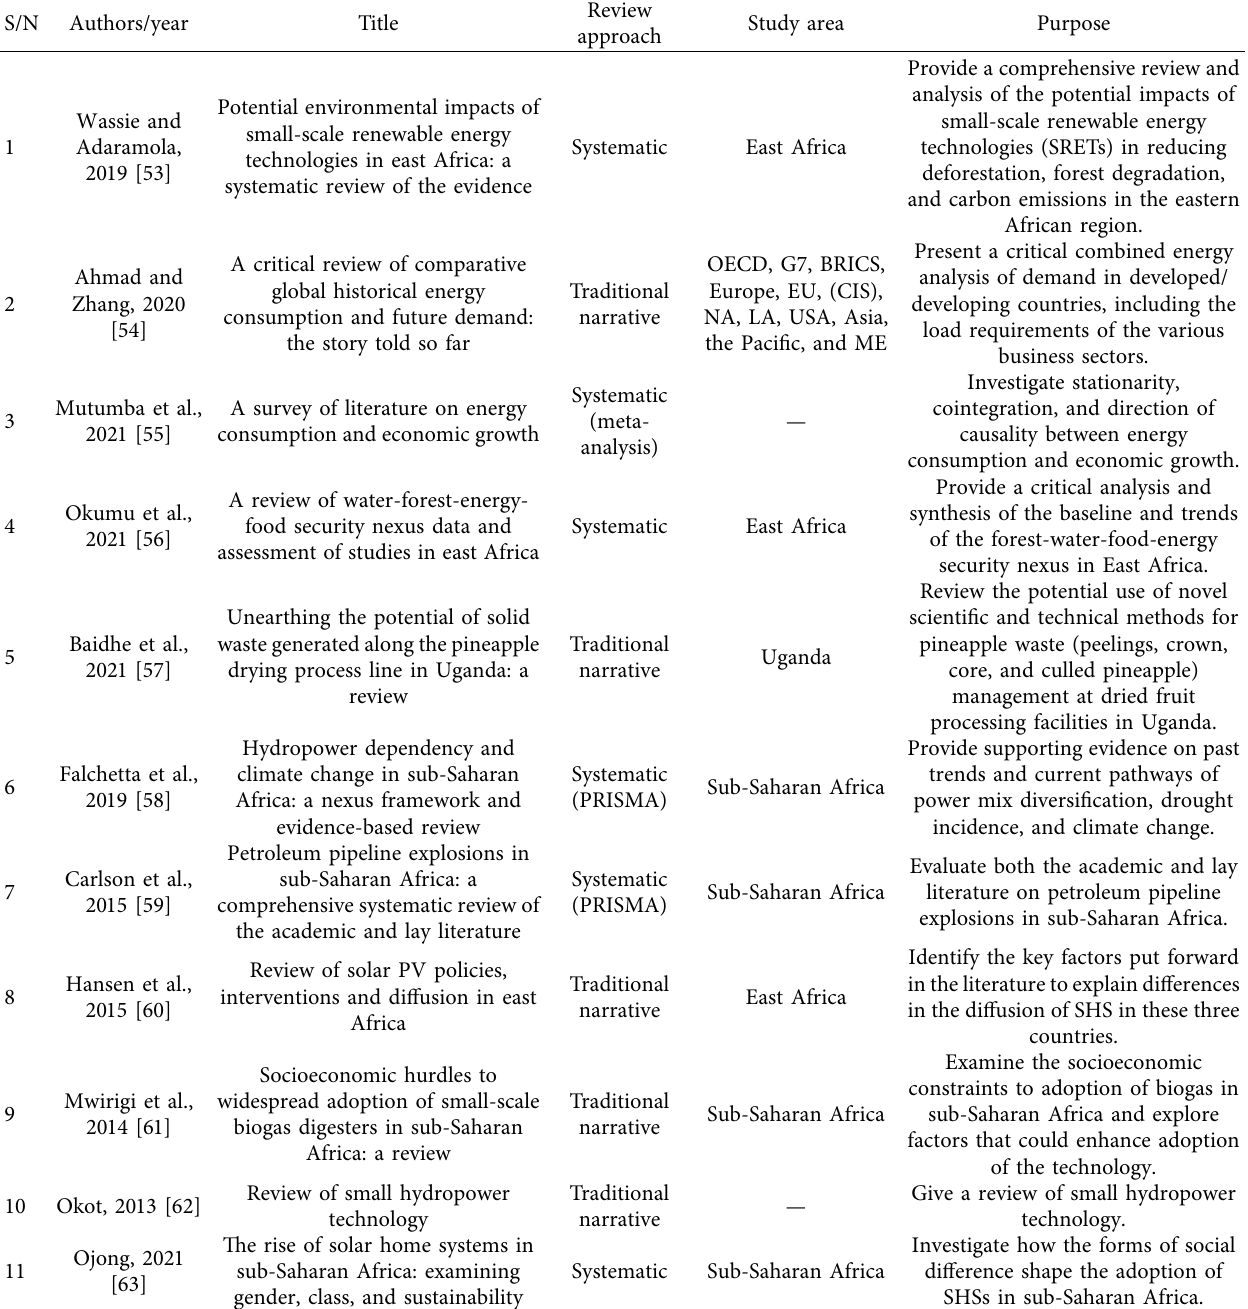
Table 1: Summary of previous review papers on energy